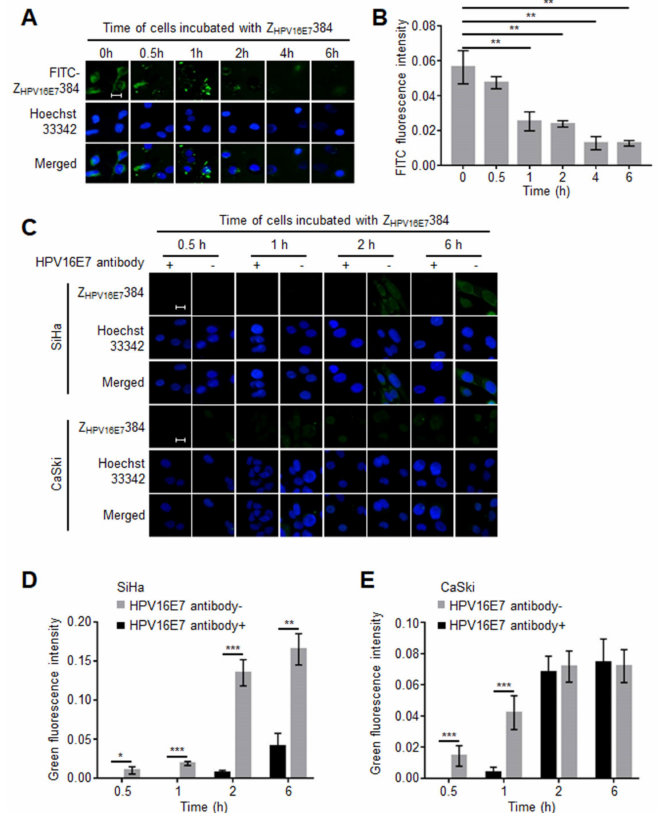
Figure 4. HPV16 E7 was involved in Z HPV16E7 384 internalization. ( A ) A free affibody blocking assay was performed to evaluate whether the Z HPV16E7 384 internalization depended on some cellular adapter proteins. The SiHa cells were pre-incubated with free Z HPV16E7 384 for different time periods and then incubated with FITC-Z HPV16E7 384 (Green). Cell nuclei were stained with Hoechst33342 (blue). Scale bar = 20 µ m. ( B ) The intensity of green fluorescence in ( A ) was analyzed. ( C ) A HPV16E7 antibody blocking assay was performed to evaluate whether the HPV16E7 protein played a role during Z HPV16E7 384 internalization. The SiHa and CaSki cells were incubated with the rabbit anti- HPV16E7 polyclonal antibody and then with Z HPV16E7 384 for different time periods. Z HPV16E7 384 was analyzed by IFA (green). Cell nuclei were counterstained with Hoechst33342 (blue). Cells incubated only with Z HPV16E7 384 were used as the controls. Scale bar = 20 µ m. ( D , E ) The intensity of green fluorescence in ( C ) was analyzed. The data shown are representative of three independent experiments. All experiments were performed in triplicate and data are expressed as the means ± SD ( n = 3). * p < 0.05, ** p < 0.01, *** p <